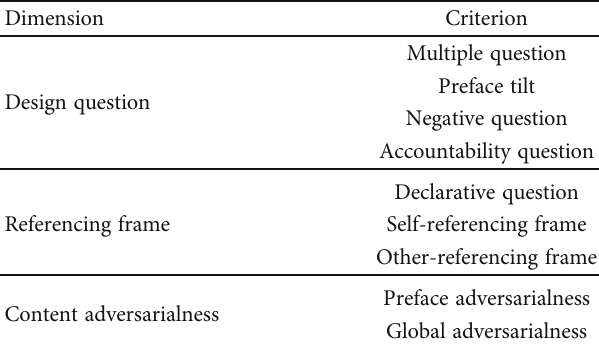
Table 1: Clayman et al. ’ s [50]